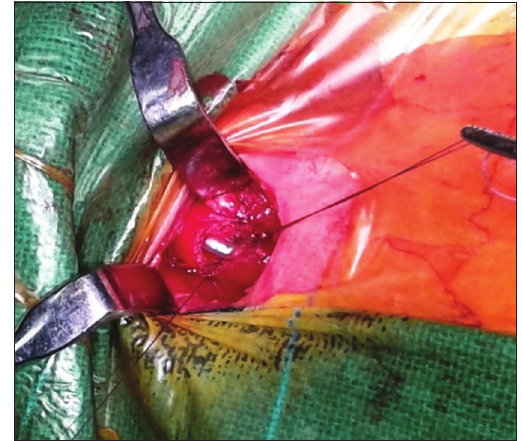
Figure 2: End-to-end tension-free primary anastomosis of both the ends of esophagus performed through cervical